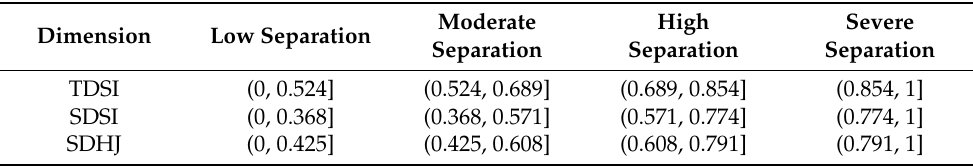
Table 1. Classification of separation degree of housing–jobs. Dimension Low Separation